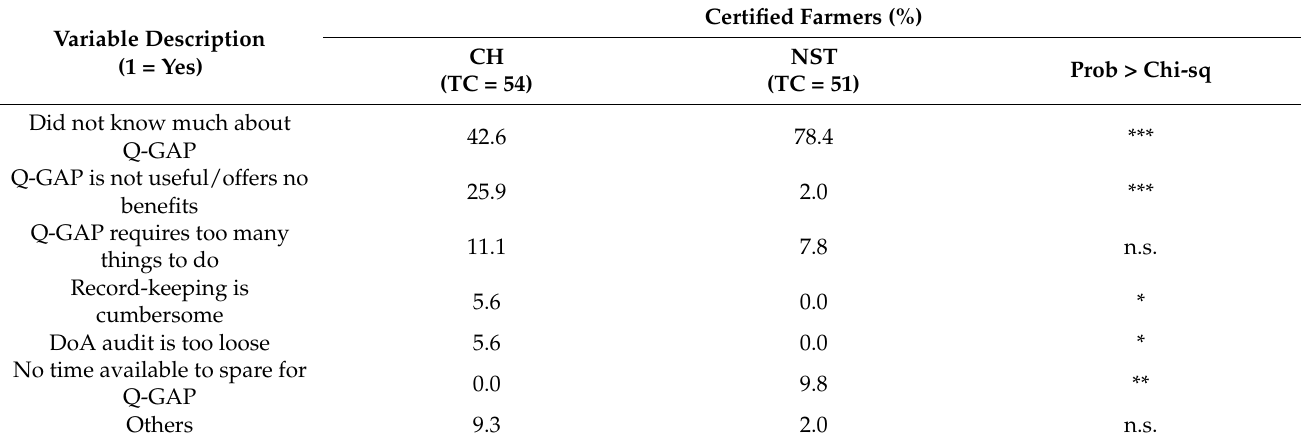
Table 4. Uncertified farmers’ reasons for not having applied for